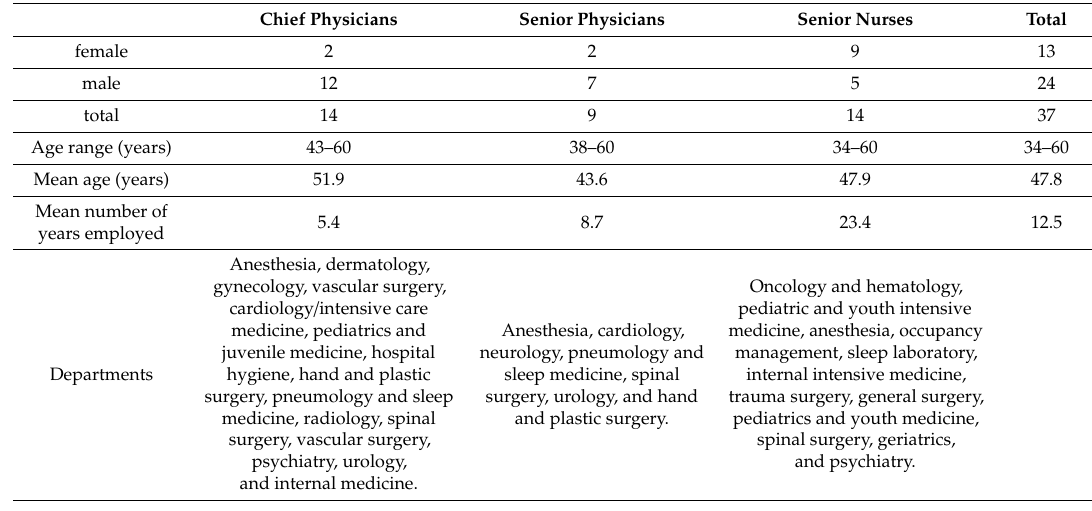
Table 1. Demographic description of the sample.